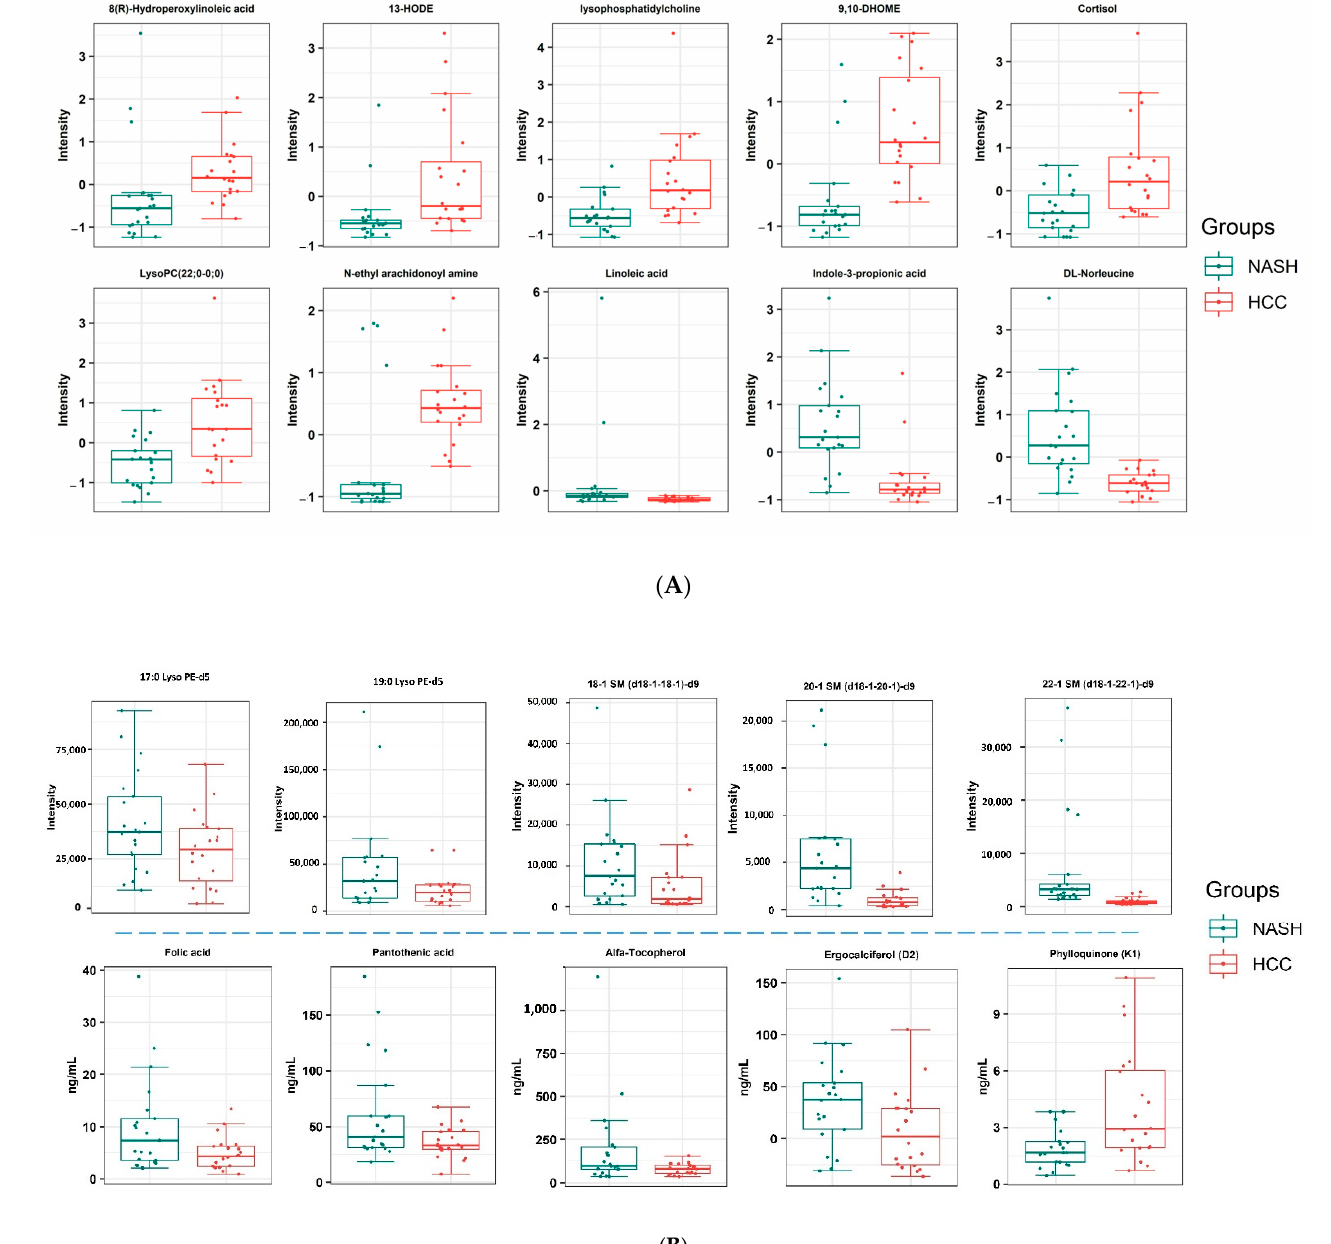
Figure 2. ( A ) Boxplot for the non-targeted molecules in NASH-HCC patients when compared to NASH patients; p ≤ 0.05, FDR 10% (q-value), and fold change ±1.5 in non-targeted analysis. ( B ) Boxplot for the targeted molecules in NASH-HCC patients when compared to NASH patients; p ≤ 0.05 and fold change ±1.5.